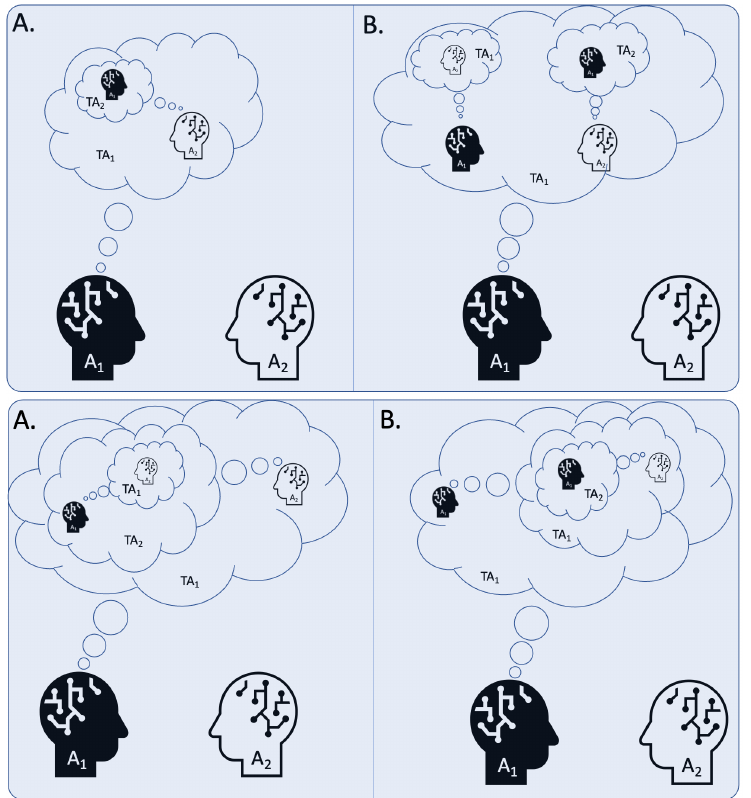
Figure 3. Top row, ( A ) two levels of strategic thinking: A 1 thinking about A 2 , thinking about A 1 . Top row, ( B ) A 1 has two distinct representations, one in which A 1 is introspecting on their model of